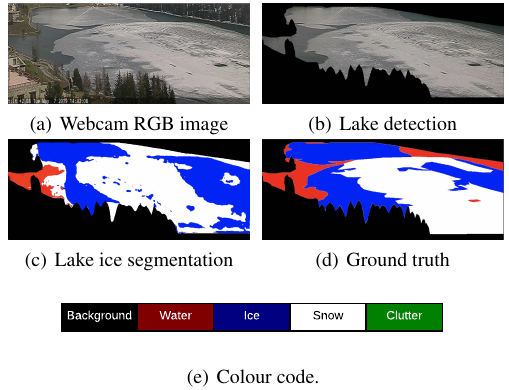
Figure 1: (a) Example webcam image of lake St. Moritz, from the Photi-LakeIce dataset, (b) lake detection result, (c) lake ice segmentation result, (d) corresponding ground truth labels and (e) the colour code used throughout the paper. PASCAL VOC dataset), to compensate for the relative scarcity of annotated